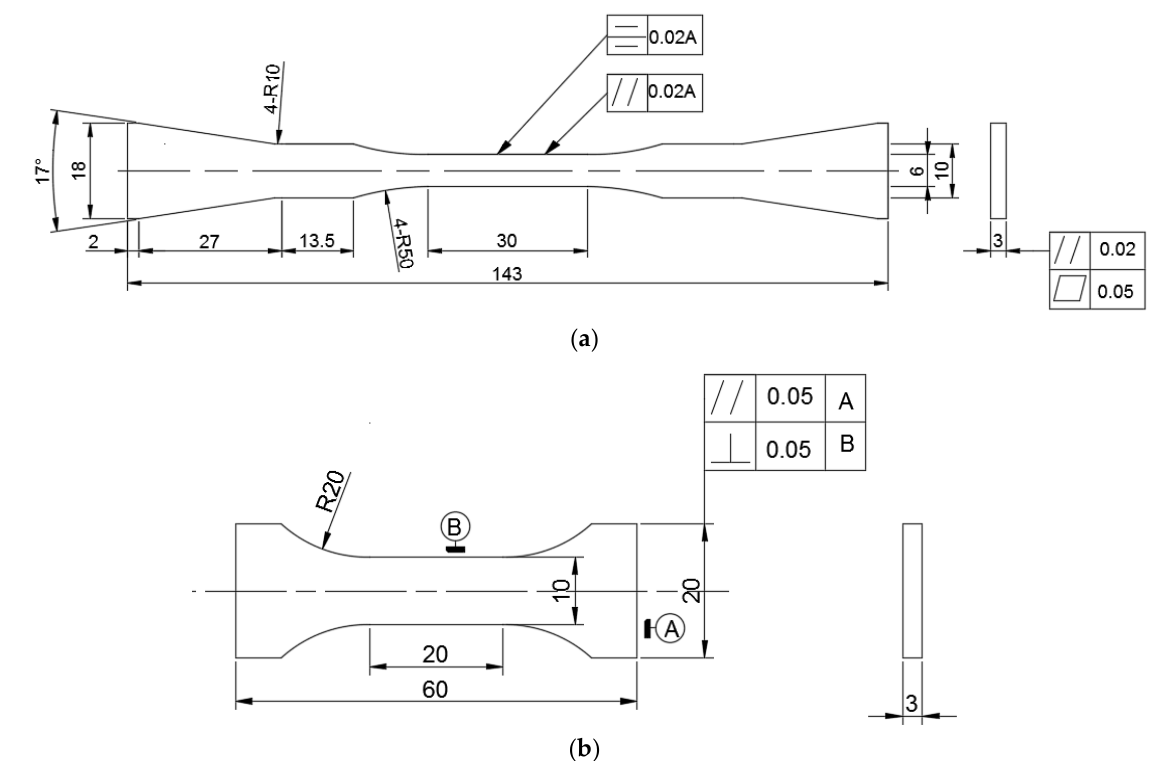
Figure 6. The configuration and dimensions of the specimen. ( a ) Tensile specimen; ( b ) Compres- sive specimen.